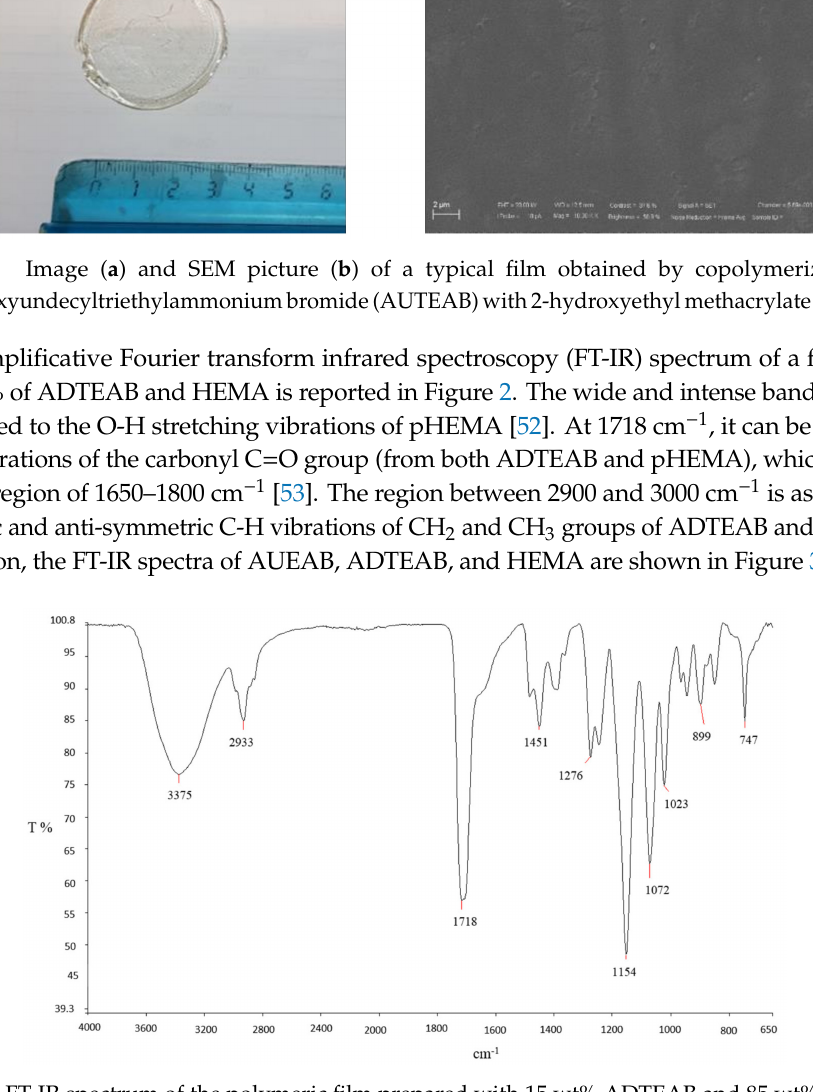
Figure 2. FT-IR spectrum of the polymeric film prepared with 15 wt% ADTEAB and 85 wt%